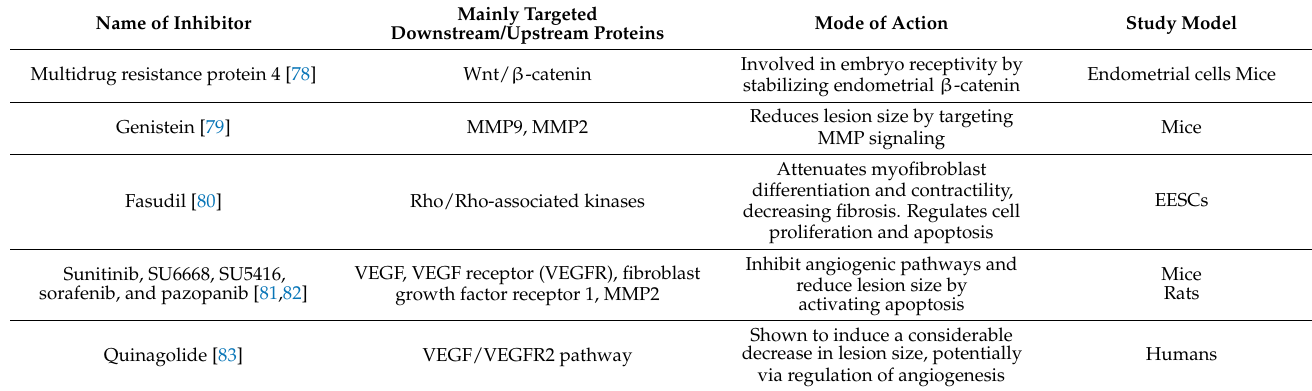
Table 8. Effect of pharmacological inhibitors on endometriosis